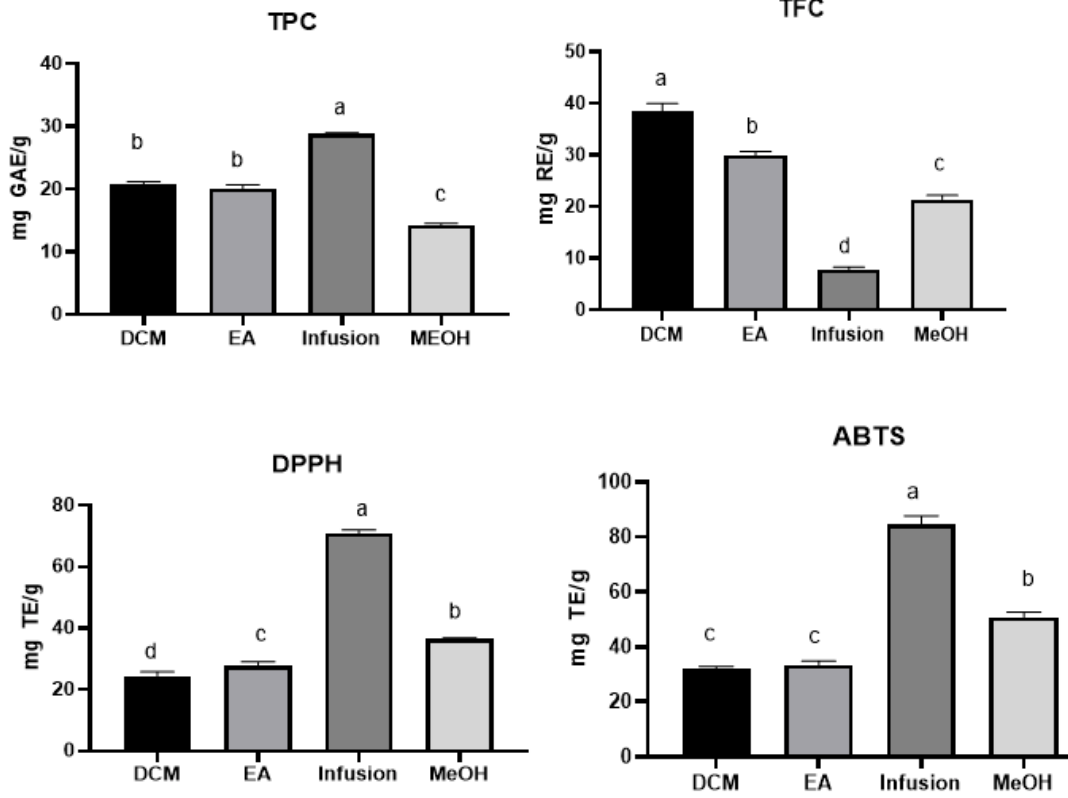
Figure 1. Total phenolic (TPC), flavonoid (TFC) content and radical scavenging abilities (1,1-diphenyl-2-picrylhydrazyl (DPPH · ) radical and 2,2-azino-bis (3-ethylbenzothiazloine-6-sulfonic acid) radical cation (ABTS + ) of the tested extracts. Values expressed are means ± S.D. of three parallel measurements. GAE: Gallic acid equivalent; RE: Rutin equivalent. TE: Trolox equivalent. Based on Tukey’s assay at p < 0.05, different letters (a, b, c and d) with in each bar indicated significant differences among the tested extracts (a: the highest value).